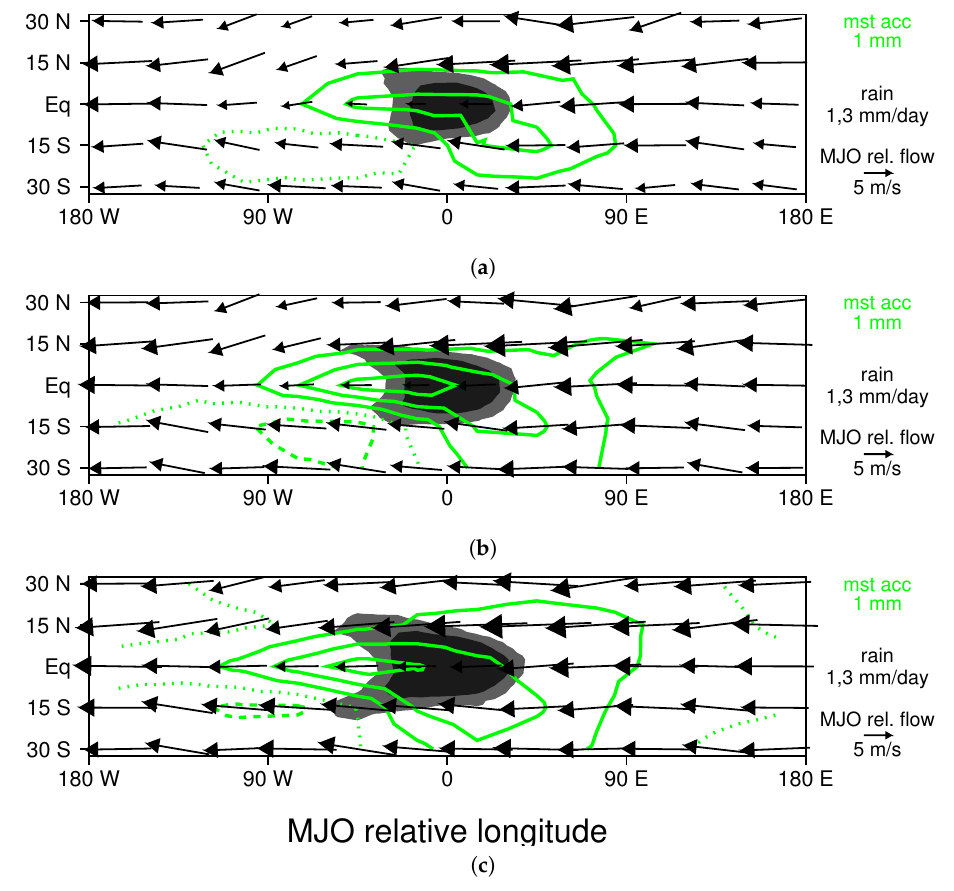
Figure 11. Accumulated change in precipitable water resulting from surface flux perturbations and low-level advection: ( a ) control simulation; ( b ) 3 K warming experiment; and ( c ) 7 K warming run. The contour interval is 1